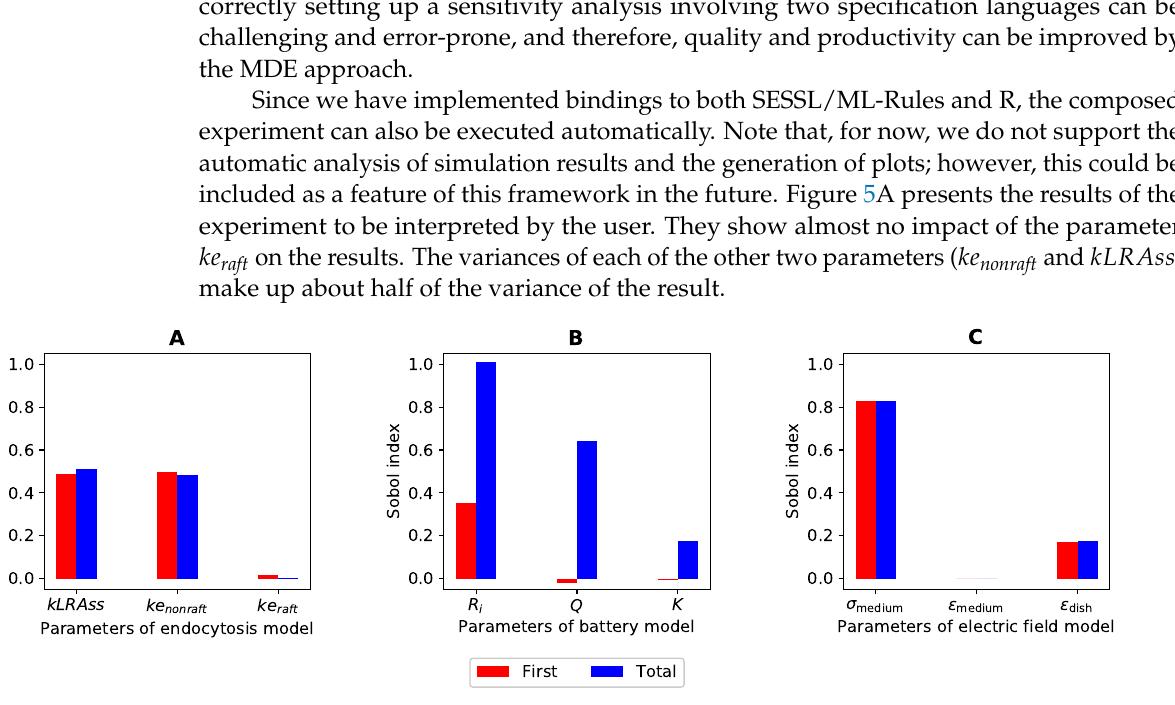
Figure 5. First- and total-order Sobol indices calculated for the three models. Whereas the Wnt model ( A ) and the electric fields model ( C ) show linear behaviors, the difference between the first- and total-order values of the battery model ( B ) indicates that the behavior of the model is governed by the interaction of